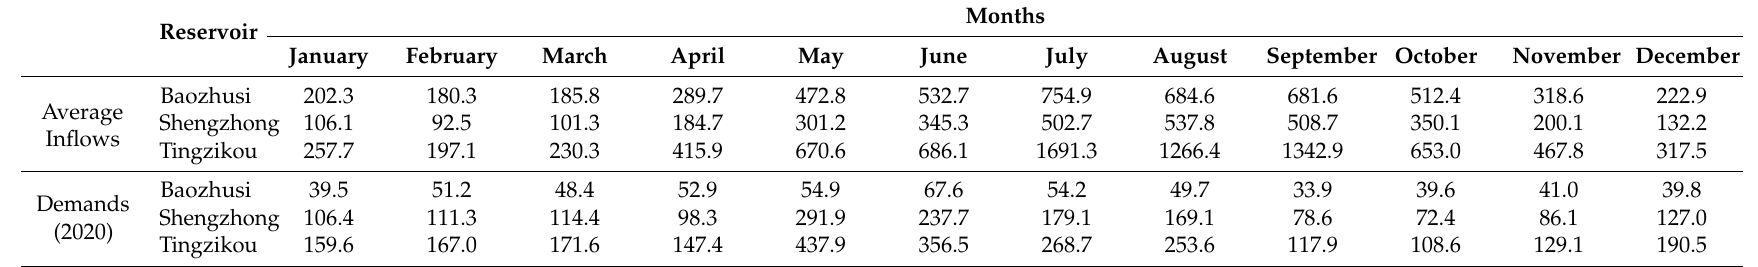
Table 3. Average natural inflows of the demonstration dry years (Y = 20) and corresponding target demands in 2020 level year (m 3 /s).